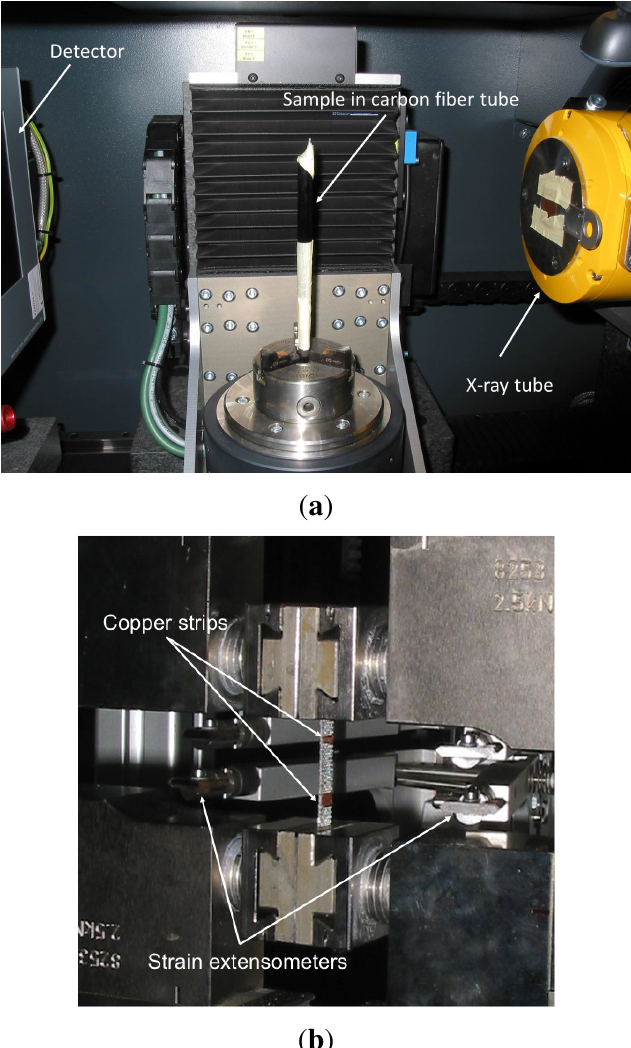
Figure 2. Experimental setup. ( a ) sample in CT; ( b ) sample in tensile test